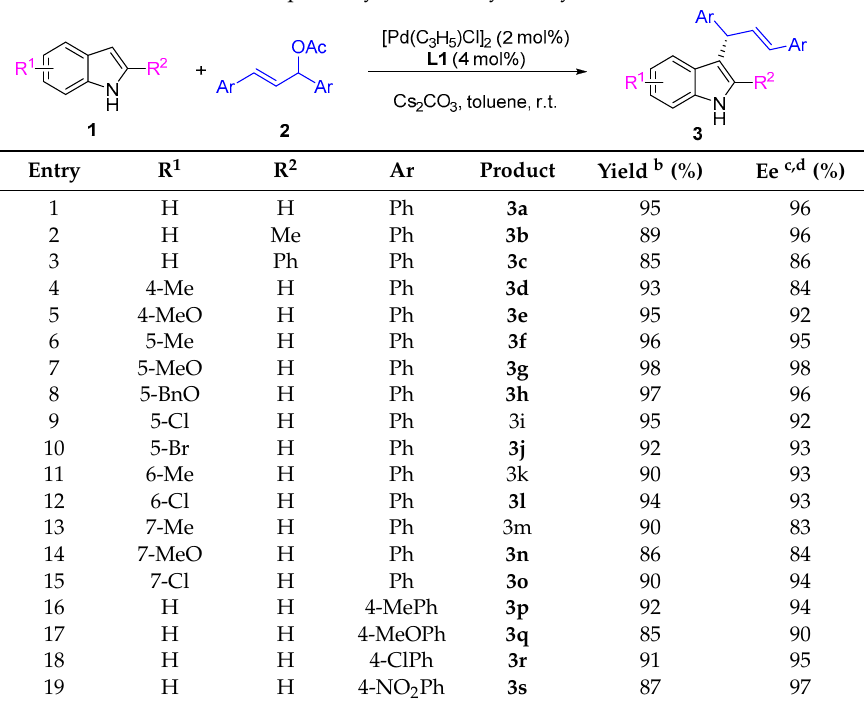
Table 3. Substrate scope of asymmetric allylic alkylation of indoles. a